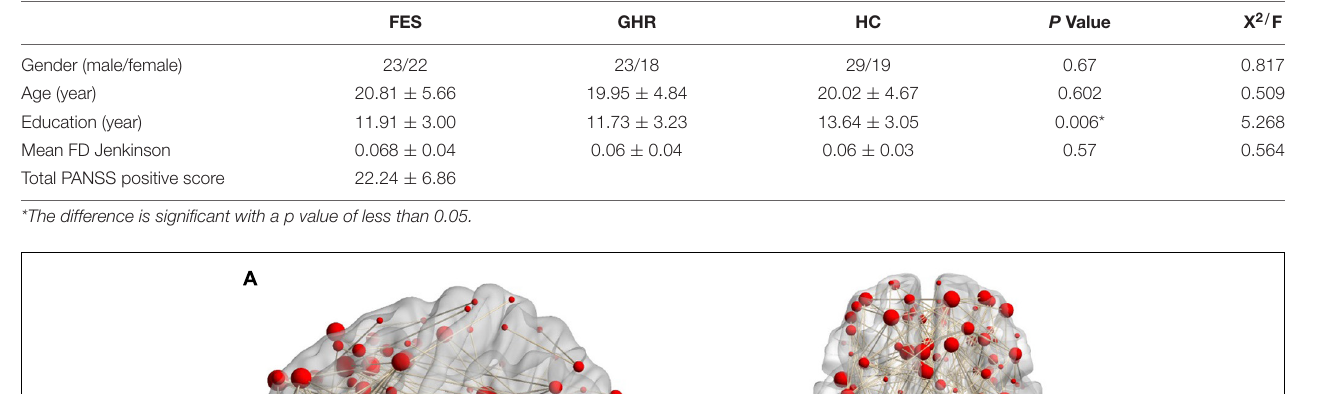
TABLE 1 | Demographic and clinical information.